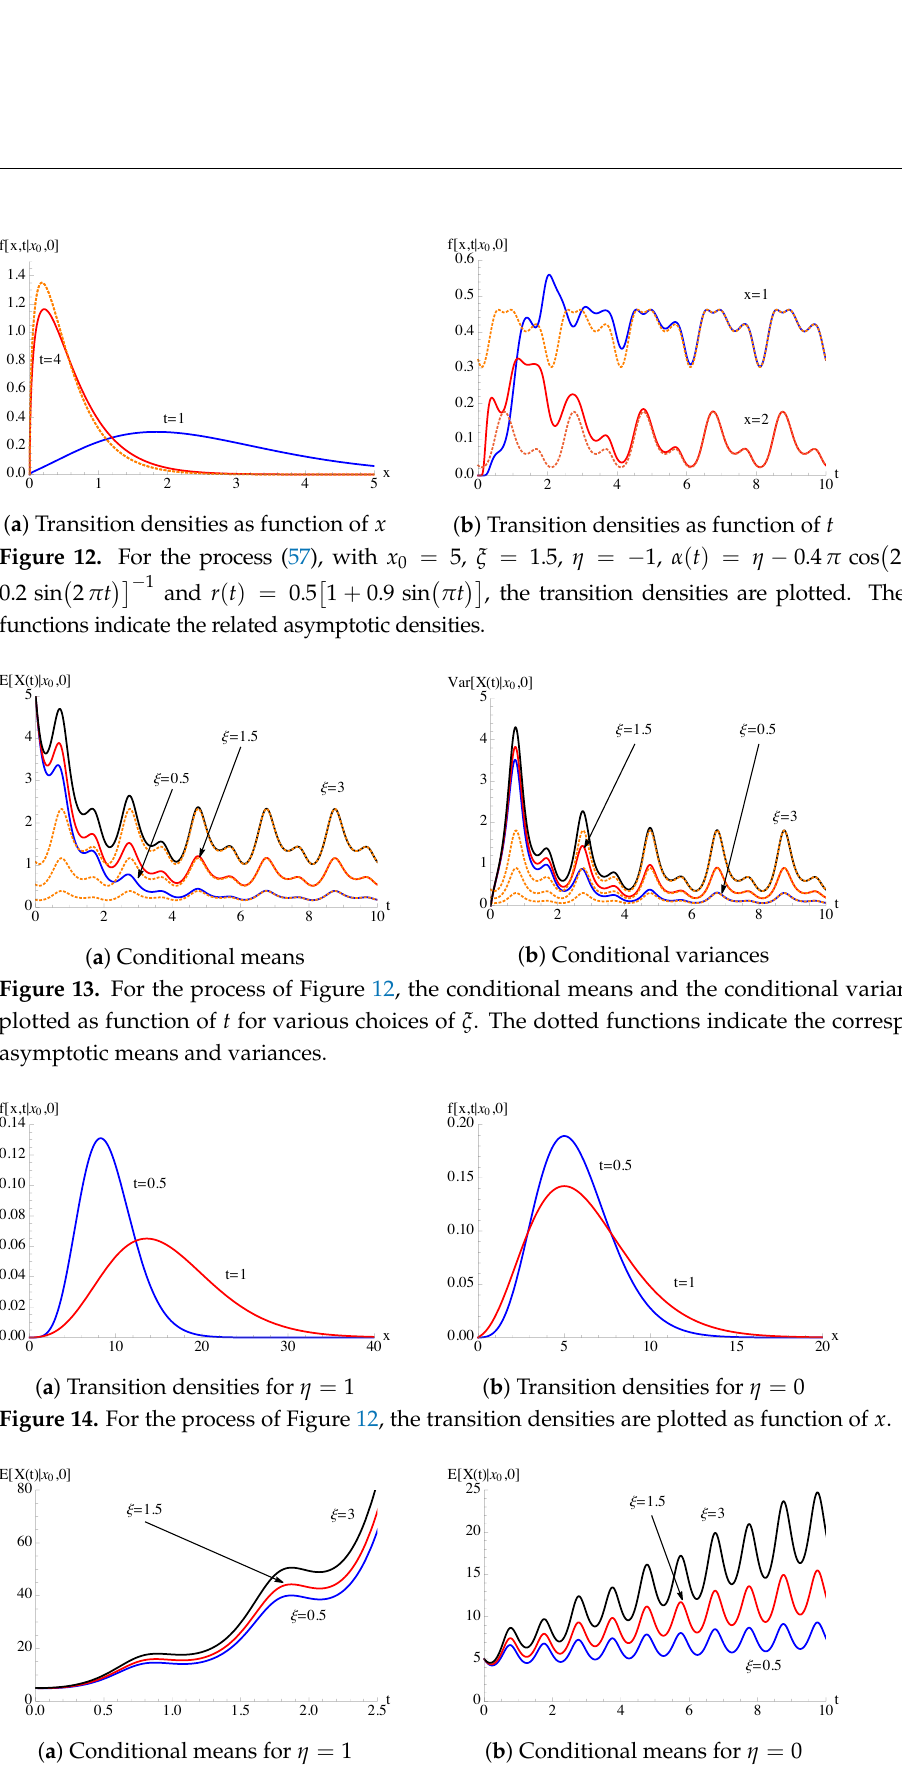
Figure 15. For the process of Figure 12, the conditional means are plotted as function of t for various choices of ξ